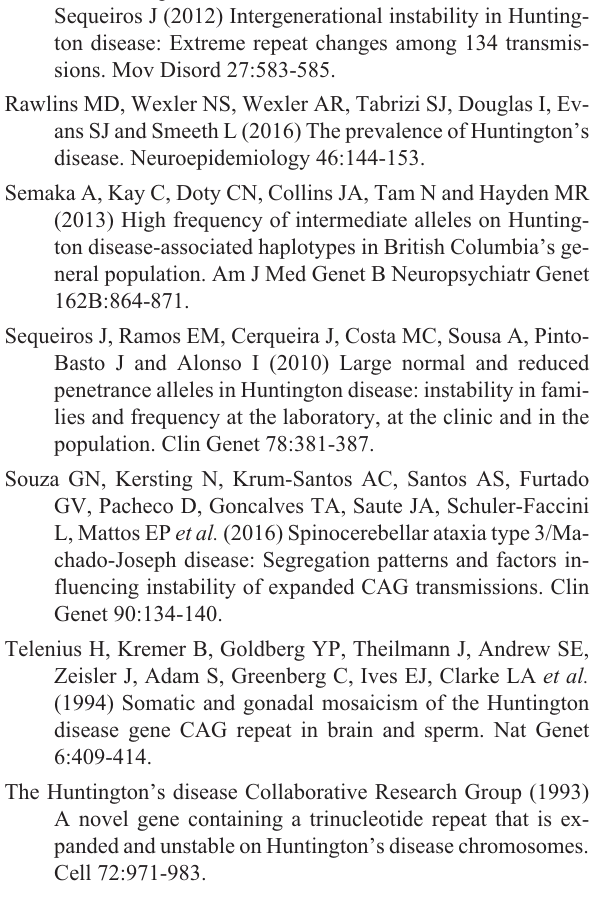
Figure S1 - Origin of HD families from Rio Grande do Sul, compared with absolute numbers of